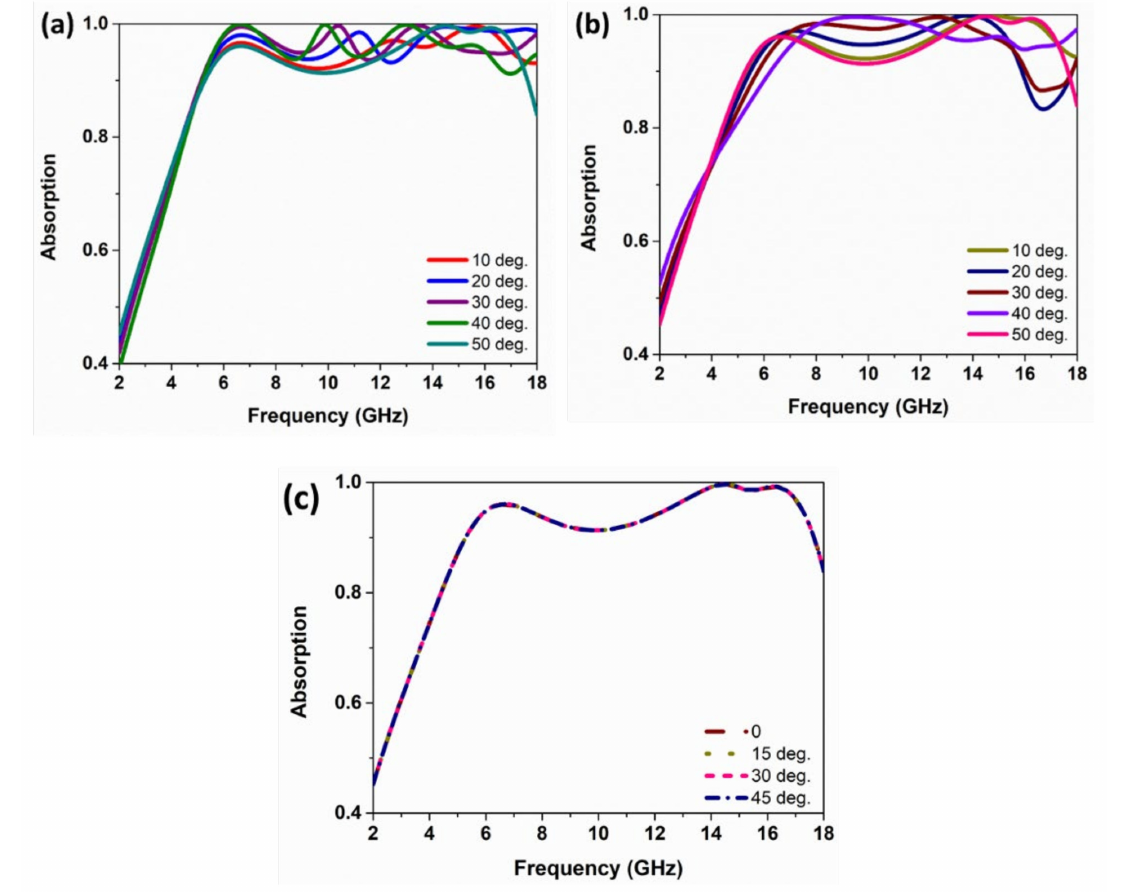
Figure 5. Simulated dependence of the absorption spectra on the incident angle for the ( a ) TE and ( b ) TM polarization, and ( c ) on the polarization angle at the normal